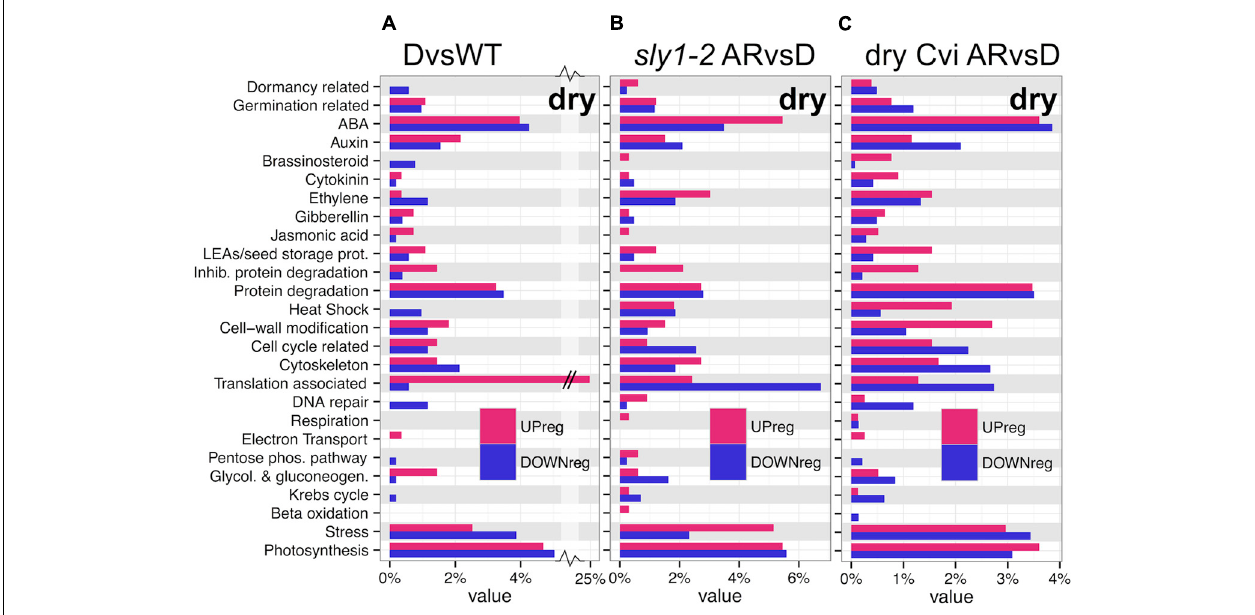
FIGURE 5 | TAGGIT gene ontology analysis of sly1- and after-ripening-regulated transcriptome differences in dry seeds. (A) sly1-2 DvsWT dry seed transcriptome differences. (B) Differences with after-ripening of sly1-2 dry seeds. (C) Differences with after-ripening of Cvi dry seeds. The value on the x -axis shows the percentage of either the total up-regulated or total down-regulated genes within a